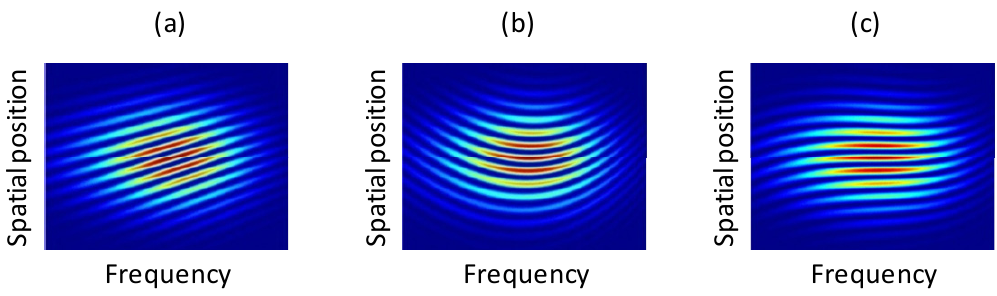
Figure 8. Demonstration of separated effect of phase derivates on simulated interferograms. The values of the applied phase derivates are GD = 60 fs ( a ), GDD = 200 fs 2 ( b ) and TOD = 2400 fs 3 ( c ),